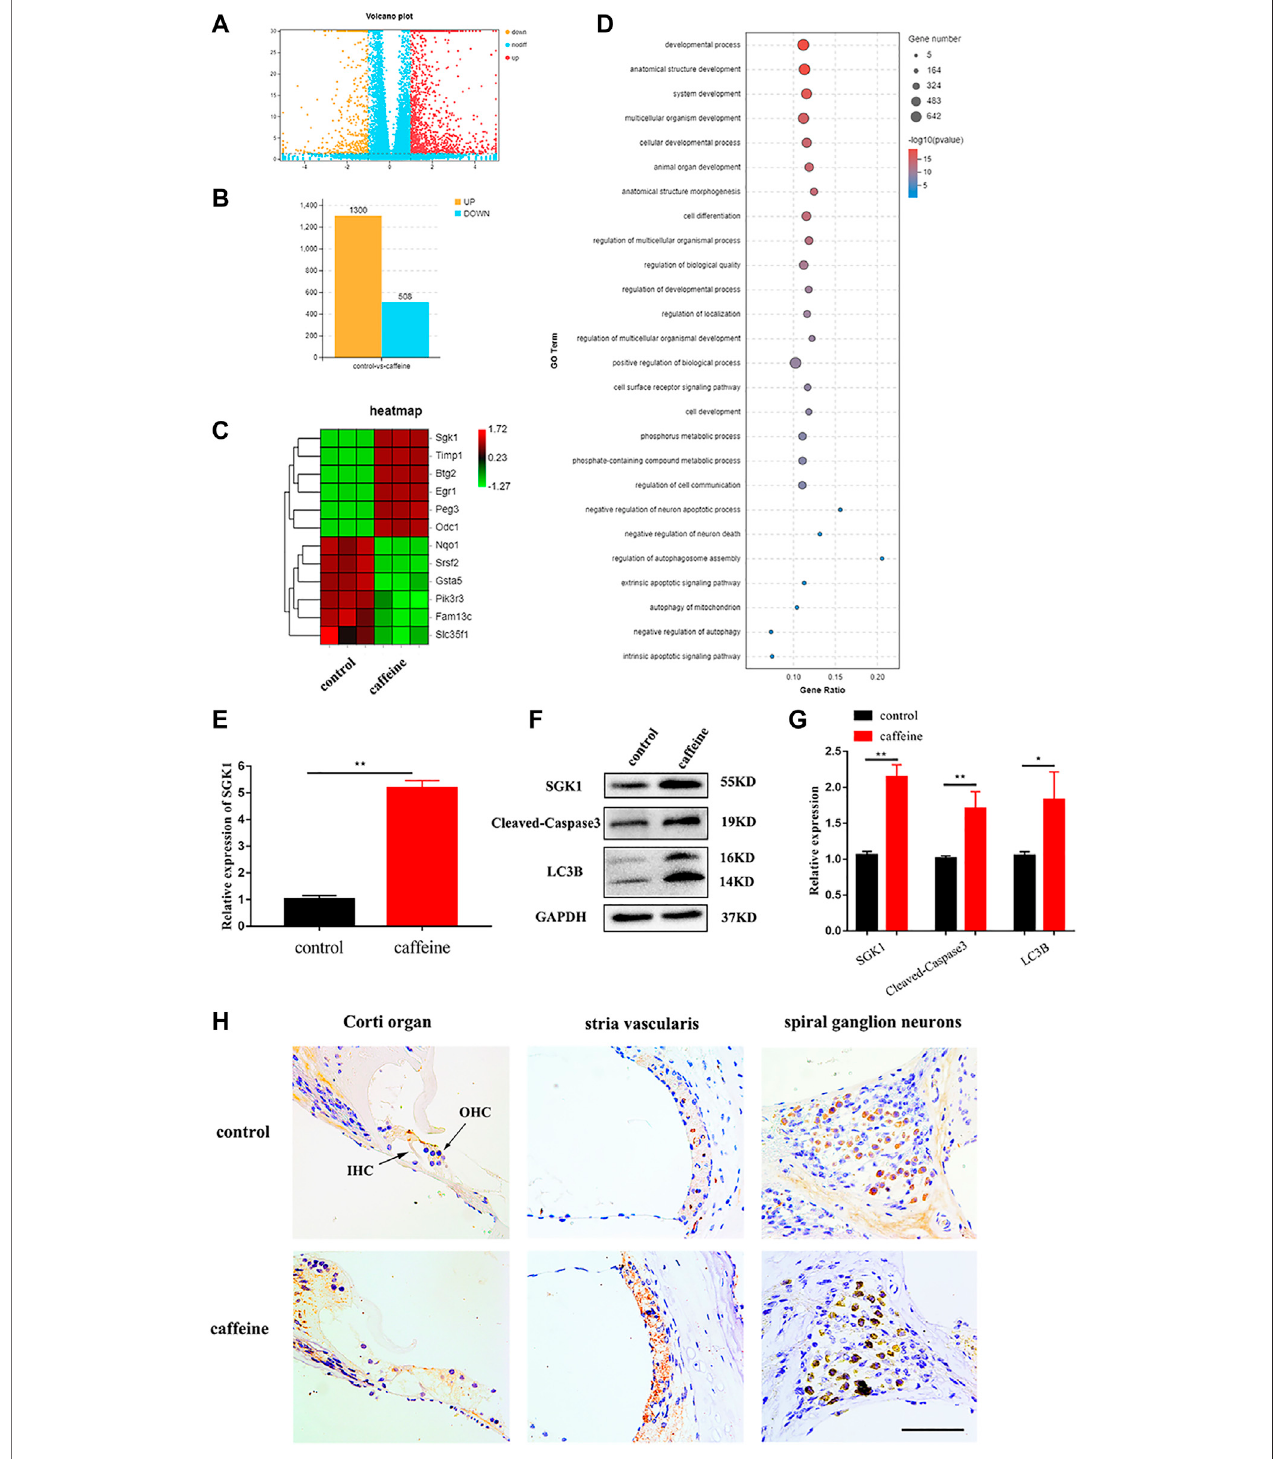
FIGURE 2 | Differentially expressed mRNA in the cochlea of C57BL/6 mice with 120 mg/kg caffeine and control. (A) Volcano plot showing the differentially expressed mRNAs in caffeine (120 mg/kg/day, continuous injection for 14 days) treatment and control group (normal saline, continuous injection for 14 days). (B) The number of differentially expressed mRNAs. (C) Heat map showing hierarchical clustering of differentially expressed mRNAs. Red indicates high relative expression, and green represents low relative expression. (D) Functional enrichment of differentially expressed mRNAs. (E) Different mRNA levels of SGK1 in the caffeine and control groups were con fi rmed by qRT-PCR. Data are shown as means ± SD, **p < 0.01 . (F – G) Western blot analysis the expression of SGK1, Cleaved-Caspase3, LC3B, and GAPDH in cochlea. Data are shown as means ± SD, **p < 0.01, *p < 0.05 . (H) Immunohistochemistry (IHC) for SGK1 in the organ of Corti, spiral ganglion neuron, and stria vascularis of C57BL/6 mice. Scale bar, 100 μ m.